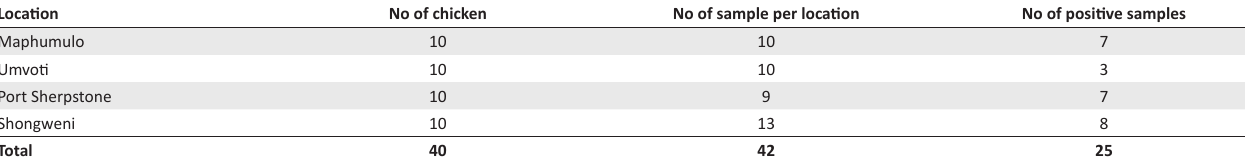
TABLE 2–A1: Summary of samples collected in free-range chickens and the outcome of Eimeria infection. Location